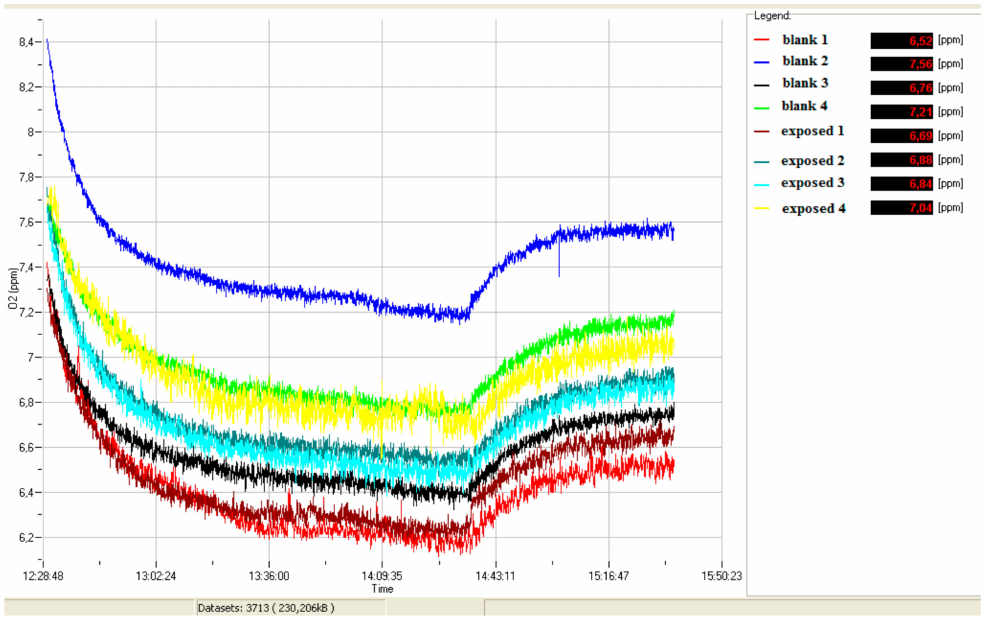
Figure 1. Exemplary curve of dissolved oxygen (ppm O 2 ) vs. time.